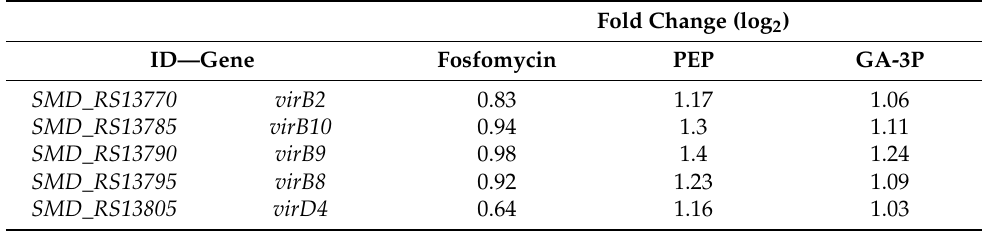
Table 3. Fold change (log 2 ) of T4SS genes presenting different levels of expression after the treatments, in comparison with the wild-type D457 strain without